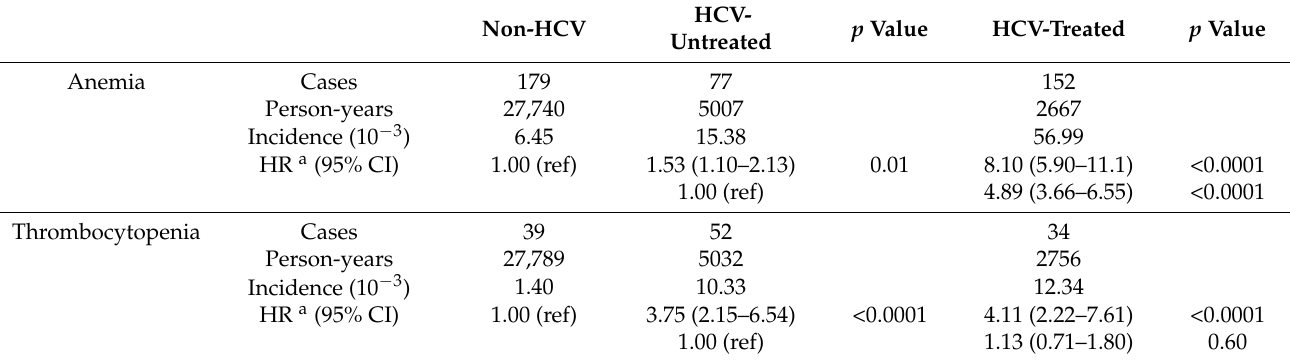
Table 4. Risk of anemia and thrombocytopenia among the non-HCV, HCV-untreated, and HCV-treated